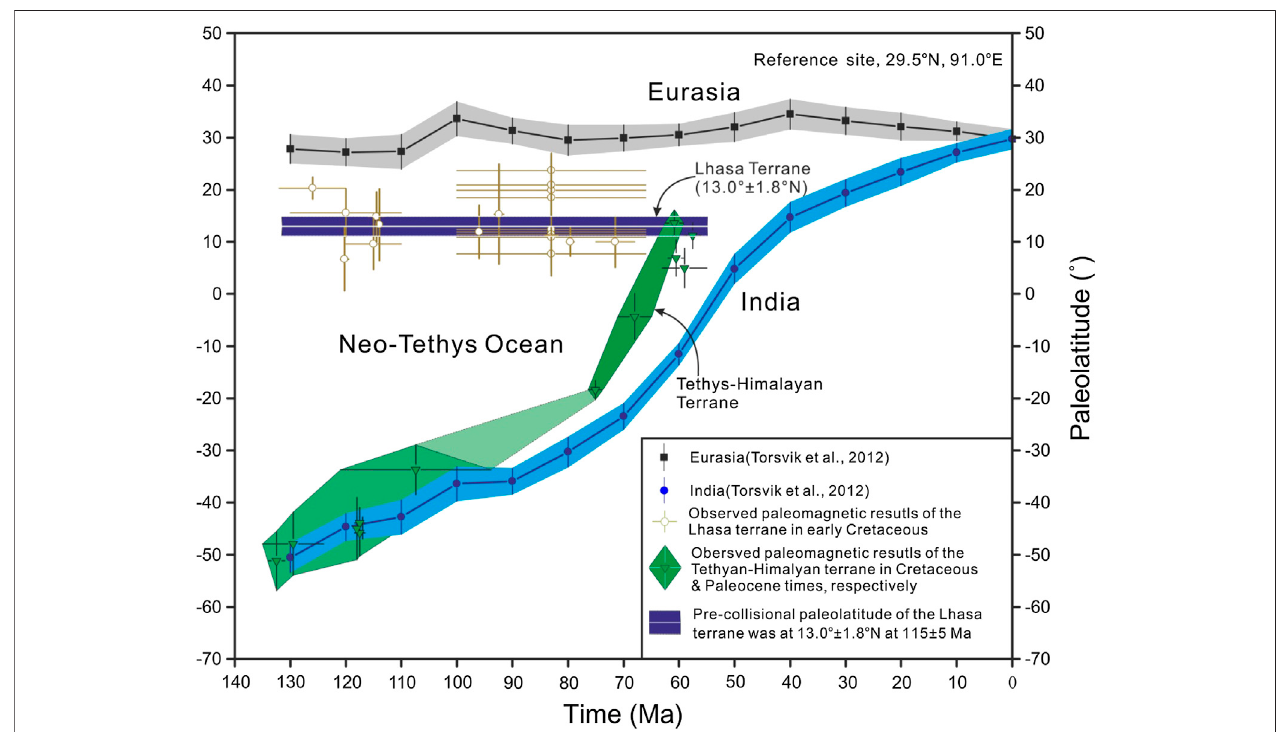
FIGURE10| PaleolatitudesevolutionoftheEurasianandIndiancontinents,theLhasaterrane,andtheTethyanHimalayanterraneasafunctionoftime.Cretaceous paleomagnetic poles of the Lhasa terrane, which were compiled from previously published results, are listed in Table 2 . All paleolatitudes were calculated for